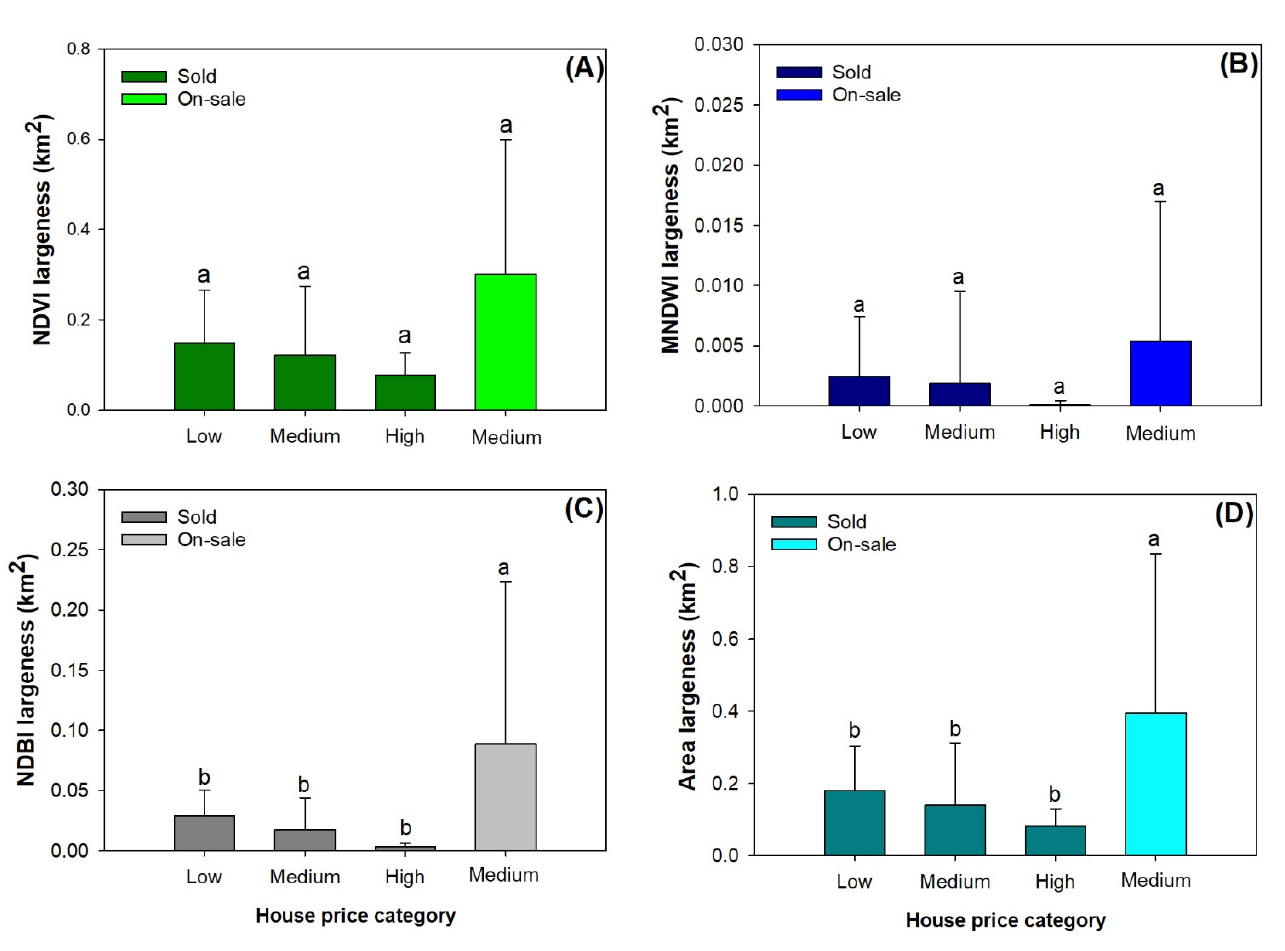
Figure 4. Landscape metrics variation in communities of largeness for NDVI ( A ), MNDWI ( B ), and NDBI ( C ) and the total area of green and blue spaces and built-up lands (Area) ( D ). Columns are means of areas and bars mark standard deviations. Different letters identify significant difference according to Duncan multiple range test at 0.05 level. Communities are classified to types of all houses sold out (Sold) and some on sale (On-sale) at price categories of low, medium, and high levels. NPE can also be regressed against NDVI largeness with a quadratic equation (Figure 5E). It was indicated that the NPE coefficient was lowest ( − 3.64) when the level of